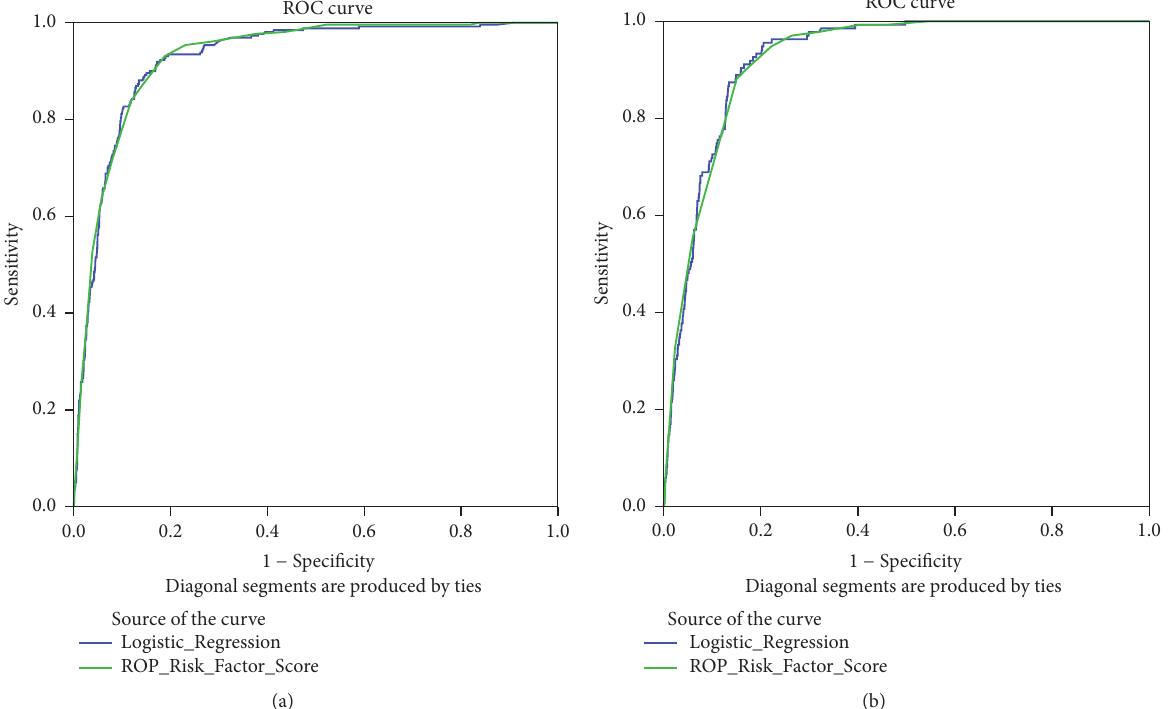
Figure 2: Receiver operating characteristic (ROC) curves showing sensitivity and specificity of predictive modeling for both diagnosis of severe ROP (a) and for treatment with laser therapy (b) using either the logistic regression model or the ROP Risk Factor